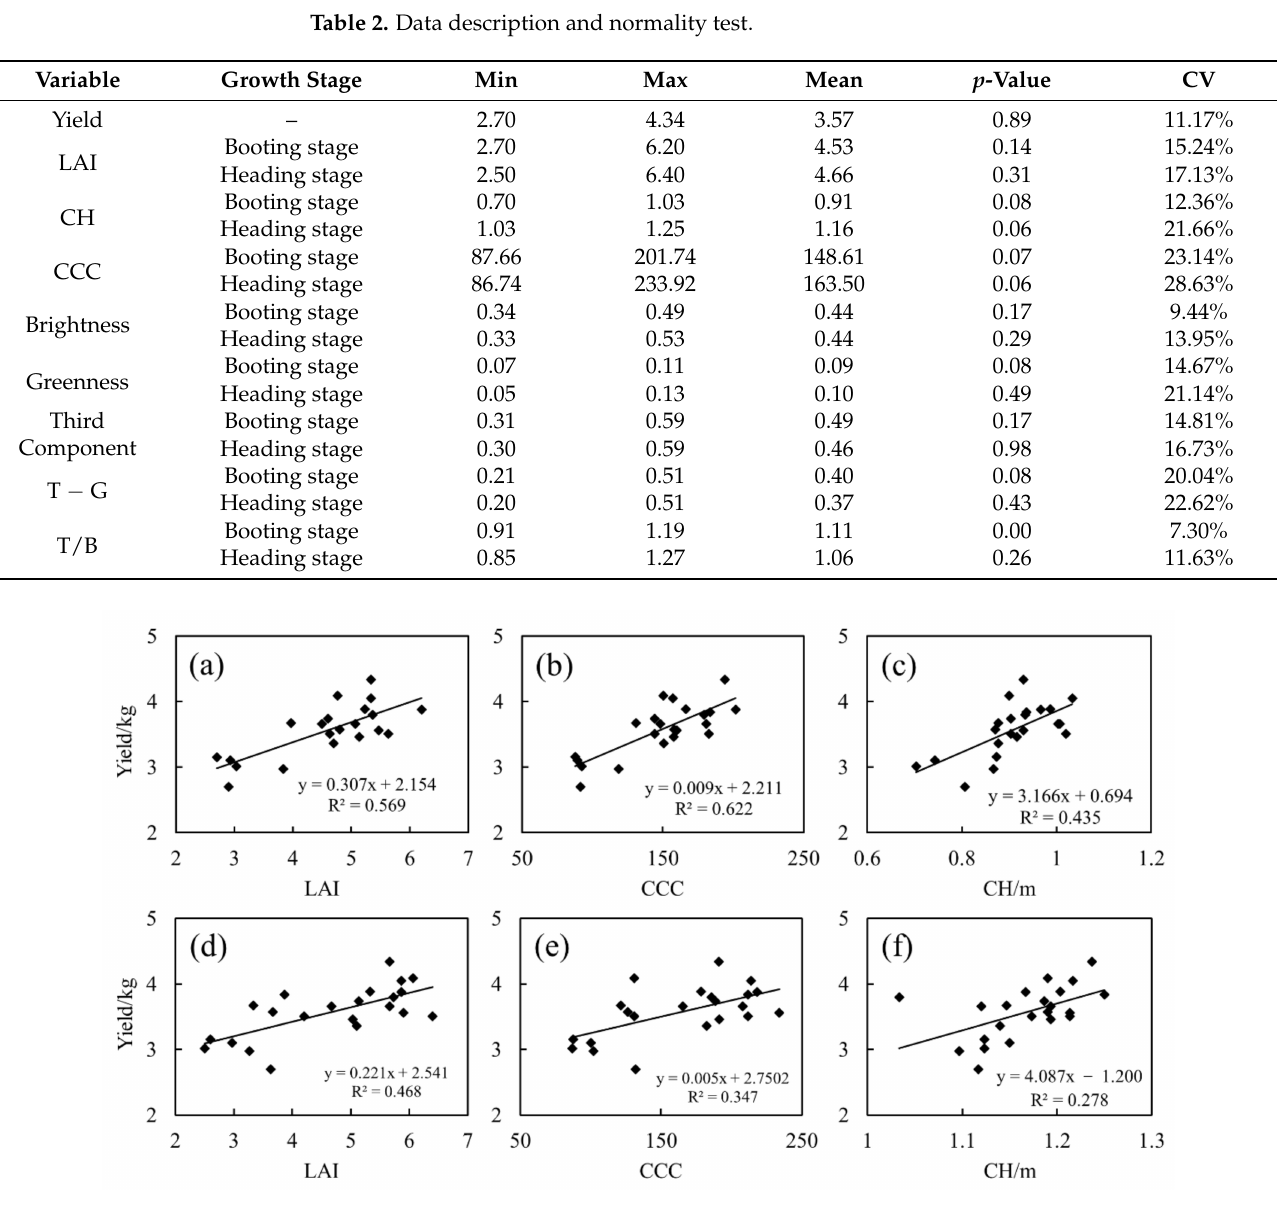
Figure 3. Fitting of ground data to yield at different growth stages: ( a – c ) booting stage; ( d – f ) heading